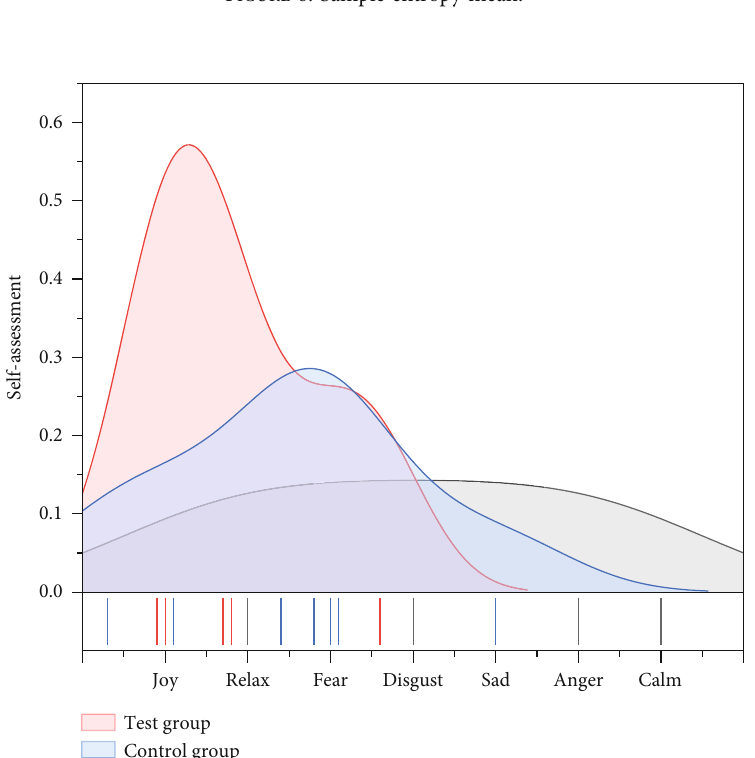
Figure 6: Sample entropy mean.